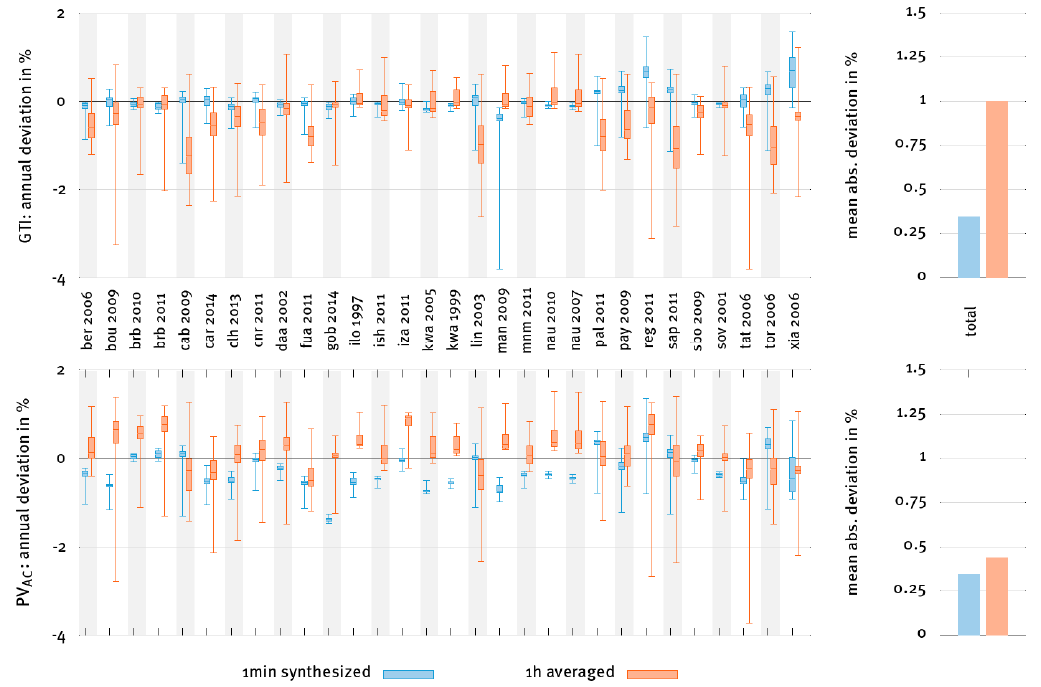
Figure 3. Influence of input data on the global horizontal irradiance (GTI, top) and the AC PV energy output (PCAC, bottom). The results of all model chains with one-minute measurement data are compared to one-minute synthesized data (blue) and one-hour averaged data (red). The boxes and whiskers contain 45 results each (nine diffuse fraction models by five transposition models). On the right, the absolute value of all single deviations is calculated and averaged over all locations.